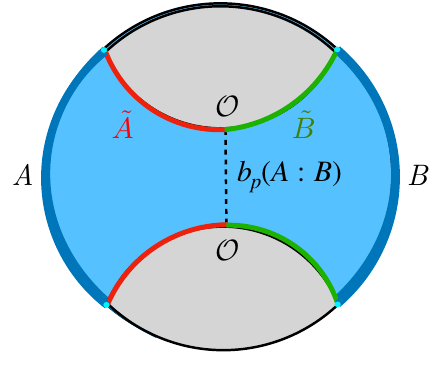
Figure 18 . The bipartite homology region cross